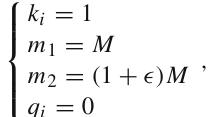
Fig. 3 The plot of β 2 against η for a CS–CS ATSW, when γ = γ c = √ kx 2 1 / 4 π . The figure implies that for domain − 1 < η < 0, β 2 can be 0 positive. A sign S implies the stable region